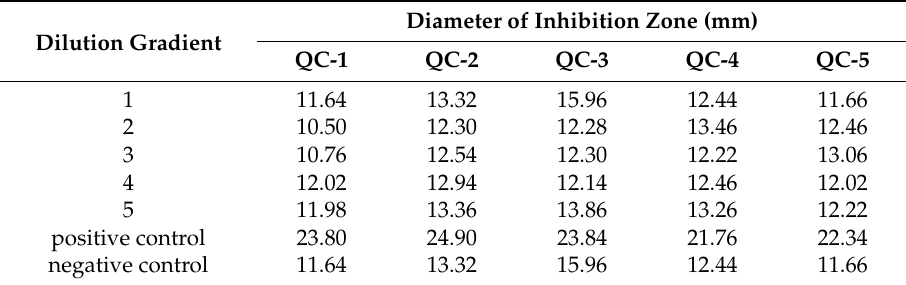
Table A1. Antibacterial activities of